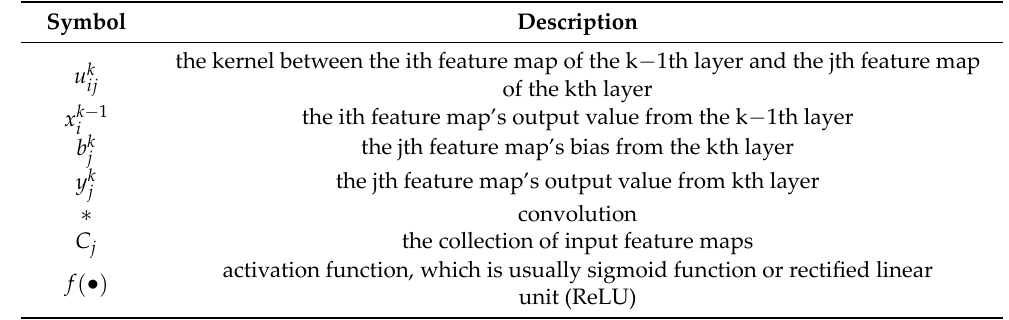
Table 1. The description of the symbols.